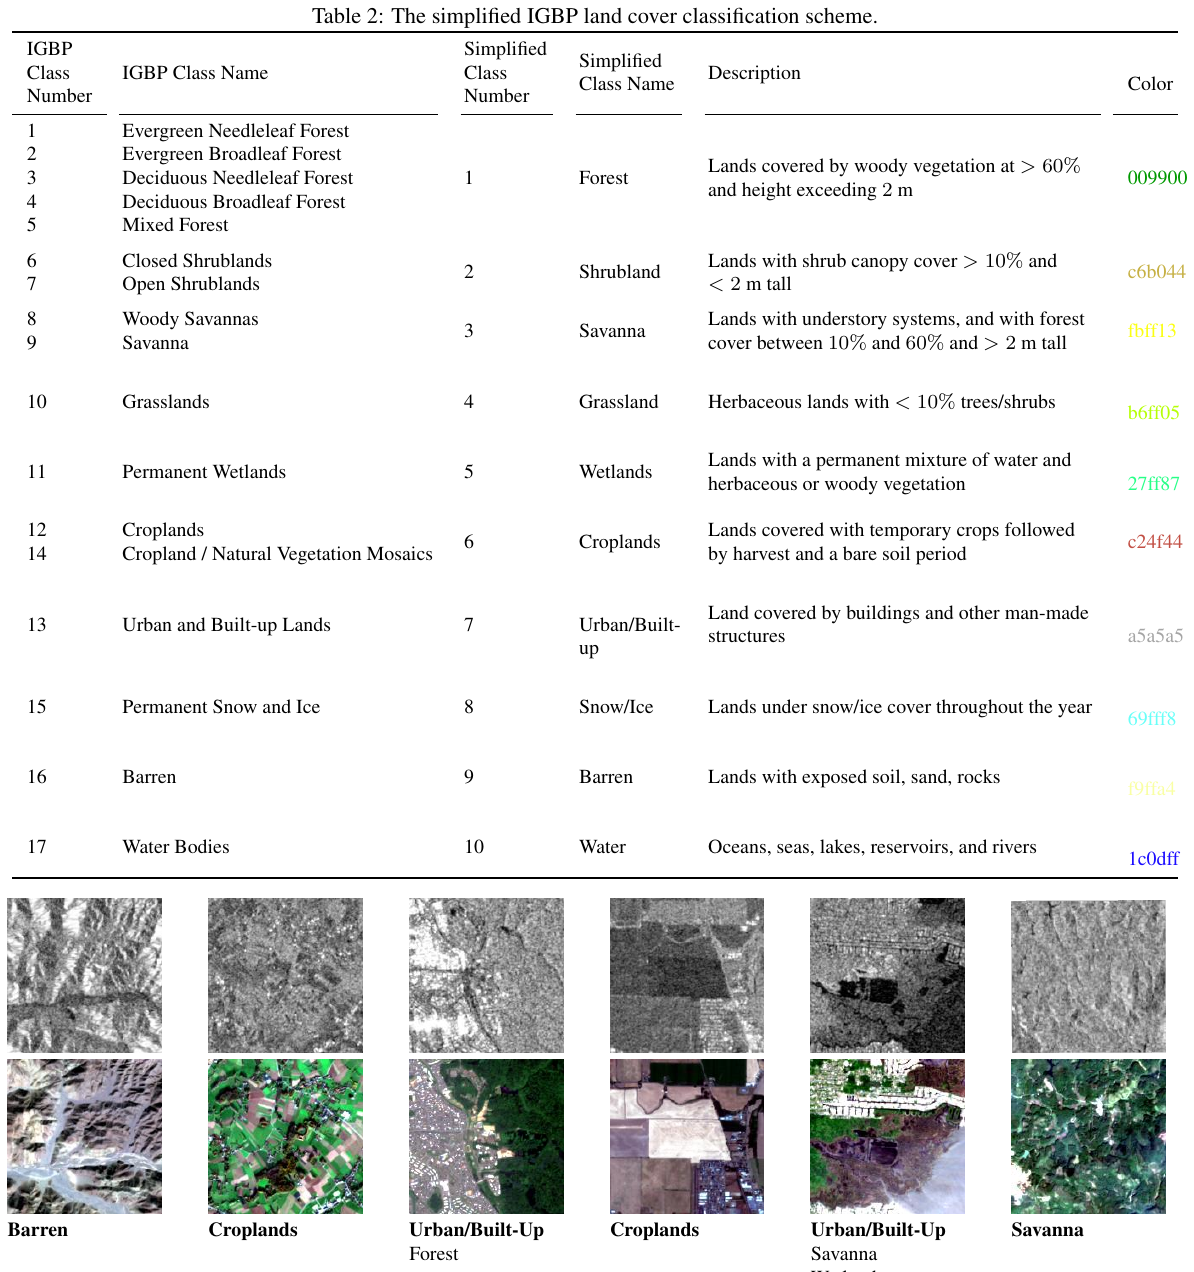
Figure 1: Some randomly selected samples from the SEN12MS dataset, including simplified IGBP land cover annotations on scene level. First row: Sentinel-1 (VV backscatter). Second row: Sentinel-2 (RGB). The main class of the scene is set in bold,